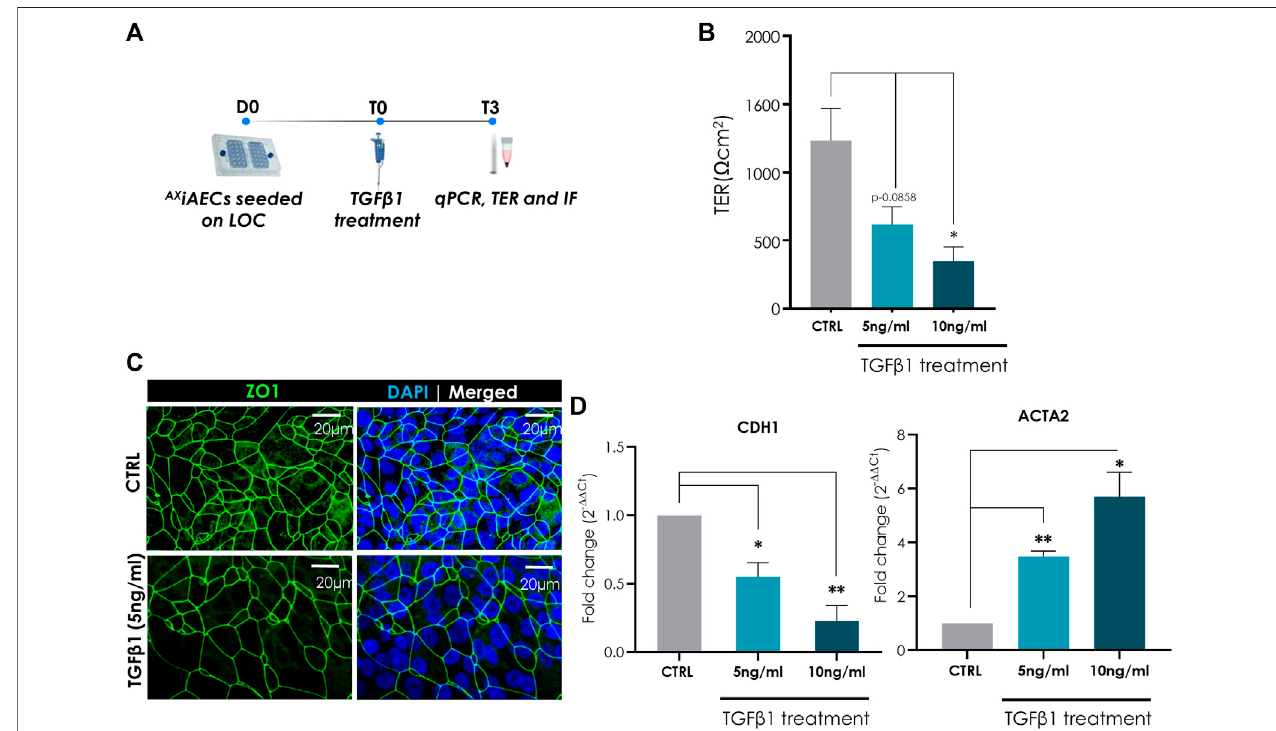
FIGURE 6 | TGF β 1 treatment induced EMT in AX iAECs on-chip. (A) Timeline and schematic of TGF β 1 treatment on day T0 in AX iAECs. Cells were harvested and fi xed for imaging 72 h (T3). (B) Signi fi cant dose-dependent reduction of TER ( Ω cm 2 ) values recorded on day T3 after treatment with TGF β 1. (C) Representative immuno fl uorescence staining of Control (untreated) and 5 ng/ml TGF β 1 treated cells (N = 2; n = 6). Cells fi xed on day T3 and stained for ZO-1 (green). Reduced fl uorescence intensity of ZO-1 observed in TGF β 1 (5 ng/ml) treated cells on-chip. (D) Normalized gene expression of EMT-associated cellular markers assessed following 3 days of treatment with TGF β 1 (N = 2; n = 4) on day T3. Data shown as mean ± SEM, * p < 0.05, ** p < 0.01, *** p <